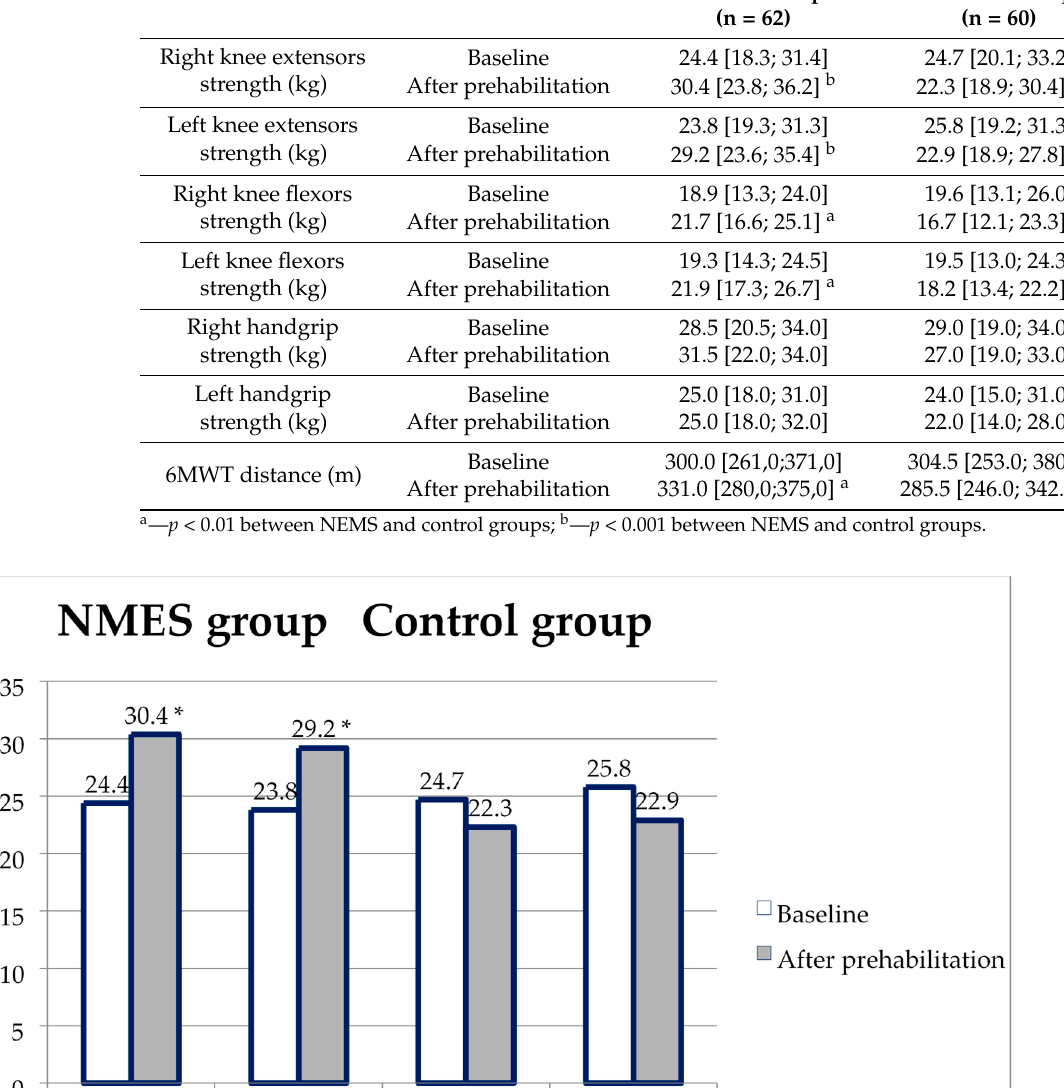
Table 3. Muscle strength of the lower and upper extremities and 6MWT during treatment time.